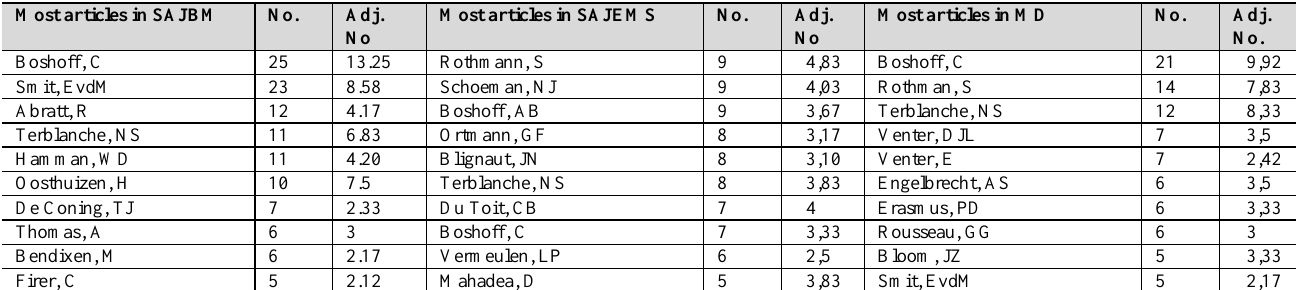
Table 2: Authors that have published most often in SAJBM, SAJEMS and MD Most articles in SAJBM